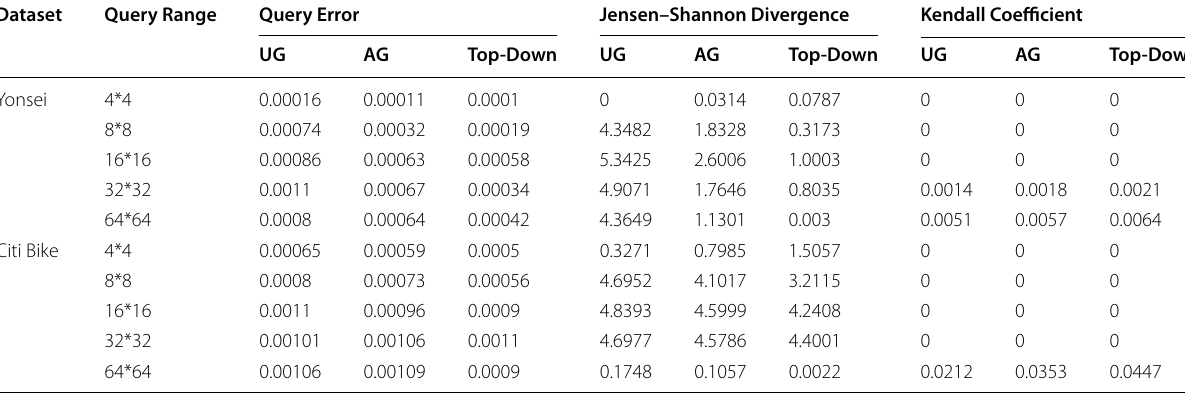
Table 5 Privacy protection average performance of different query ranges